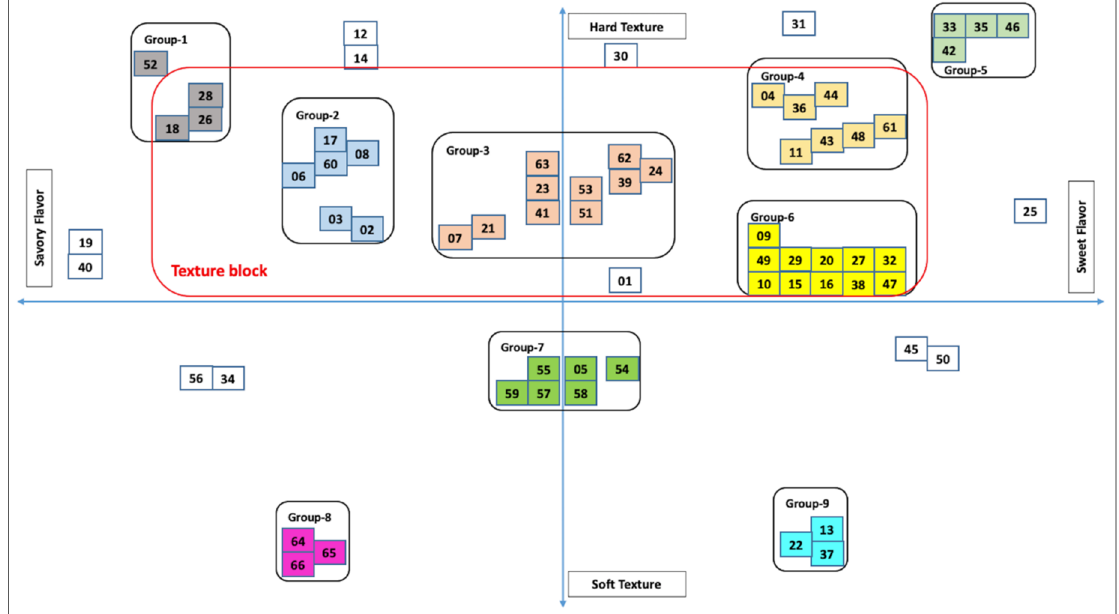
Figure 2. Projective mapping plot of the sixty-six SK snacks showing nine product groupings and outlying products (snacks are coded with 2-digit numbers and snacks with the same color are in the same group). The products’ grouping was subjective. Table 4. Group identified in the projective mapping of the SK snacks. Group number, number of snacks in each group, snack type, texture, flavor, and snack names.